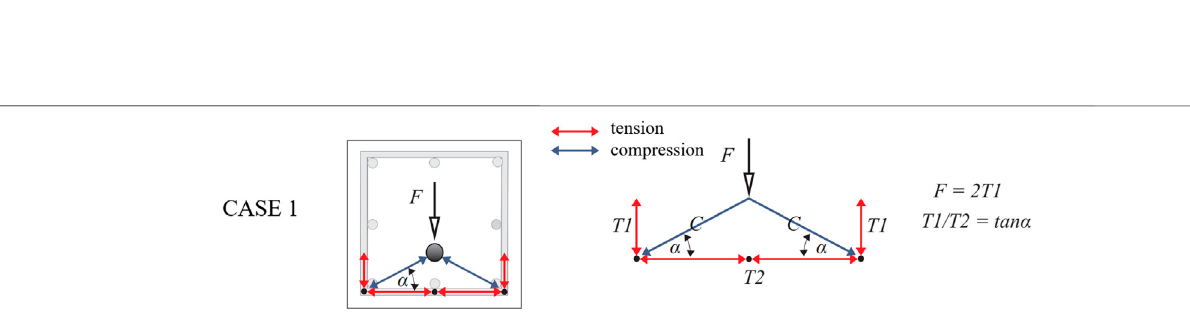
Frontiers in Built Environment |